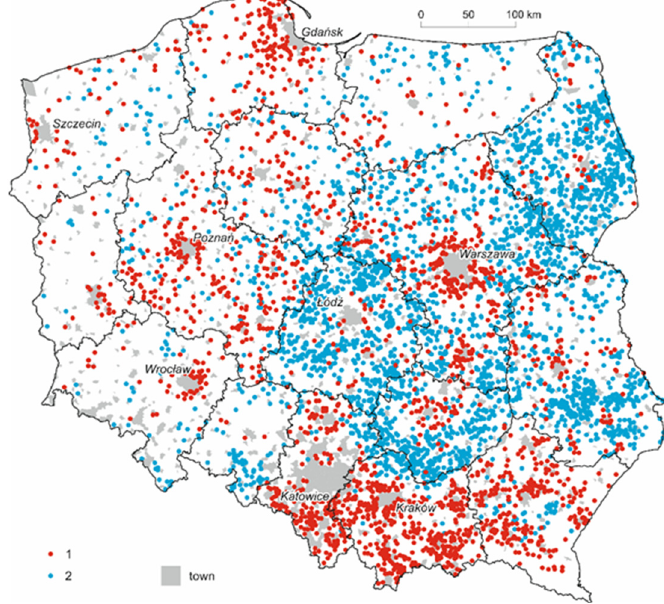
Figure 4. Villages with a homogeneous population change direction in all sub-periods, progressive (1) and regressive (2). Source: Own study based on CSO data.